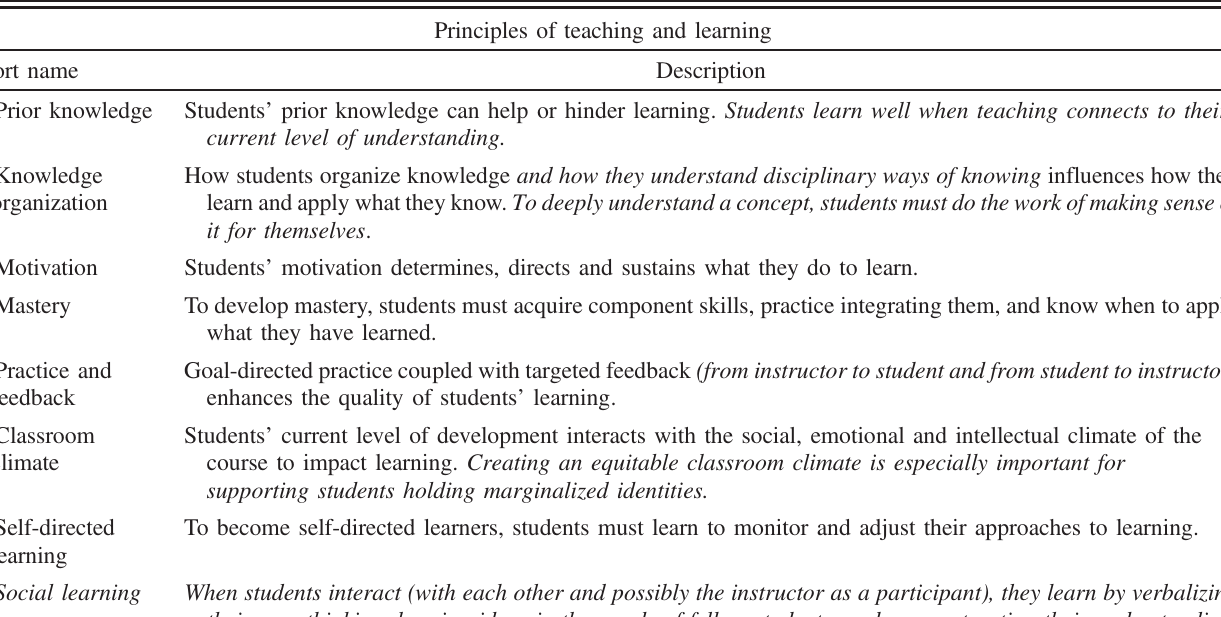
TABLE I. Principles of teaching and learning. From How Learning Works [20], with several principles broadened, and one principle added (No. 8). Pieces we have added to HLW are in italicized